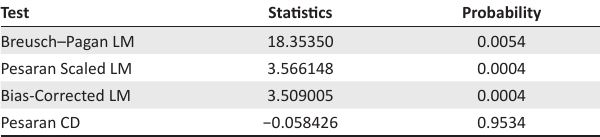
TABLE 3: Cross-sectional dependence tests.